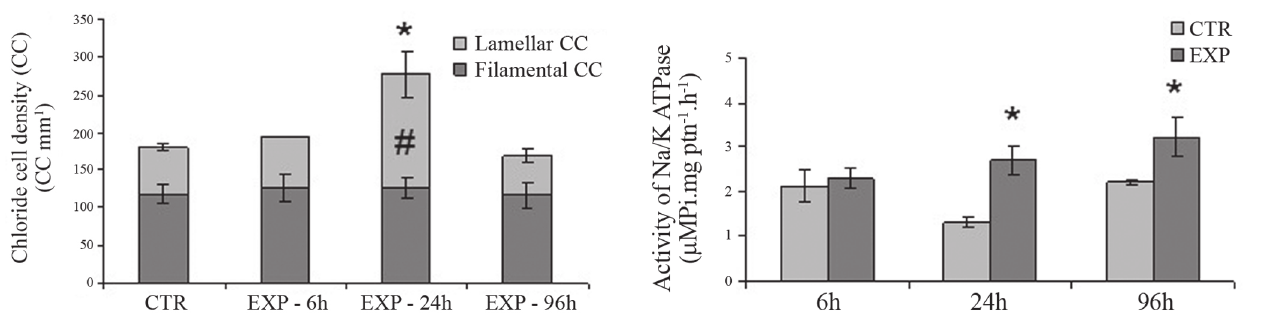
Fig. 5. Density of chloride cells (CCmm -1 ) in the lamellar and lamental regions of the gills of Prochilodus lineatus exposed to WSFG (EXP) for 6, 24 and 96h. The results obtained for control groups at each experimental period were pooled together (CTR). Data are means ± SEM (n = 10-13), asterisks indicate number of total CC different from CTR group; number sign indicate number of lamellar CC different from CTR group (P < 0.05).